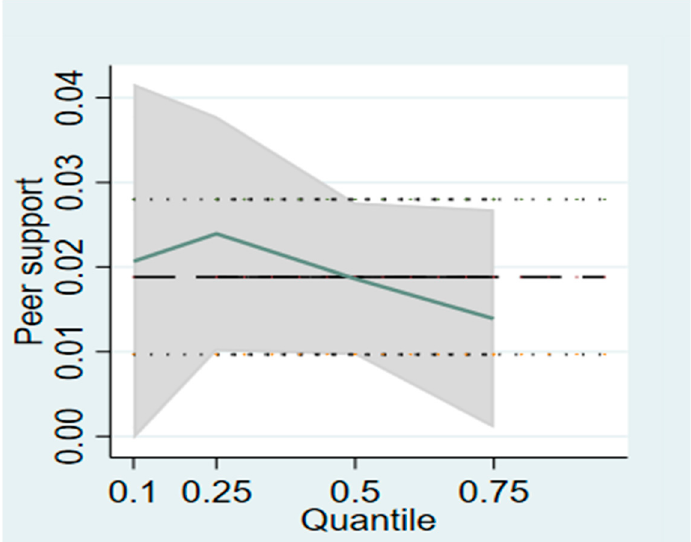
Figure 2. Trend of Influence of Peer Support on Physical Activity Energy Consumption of College Students.